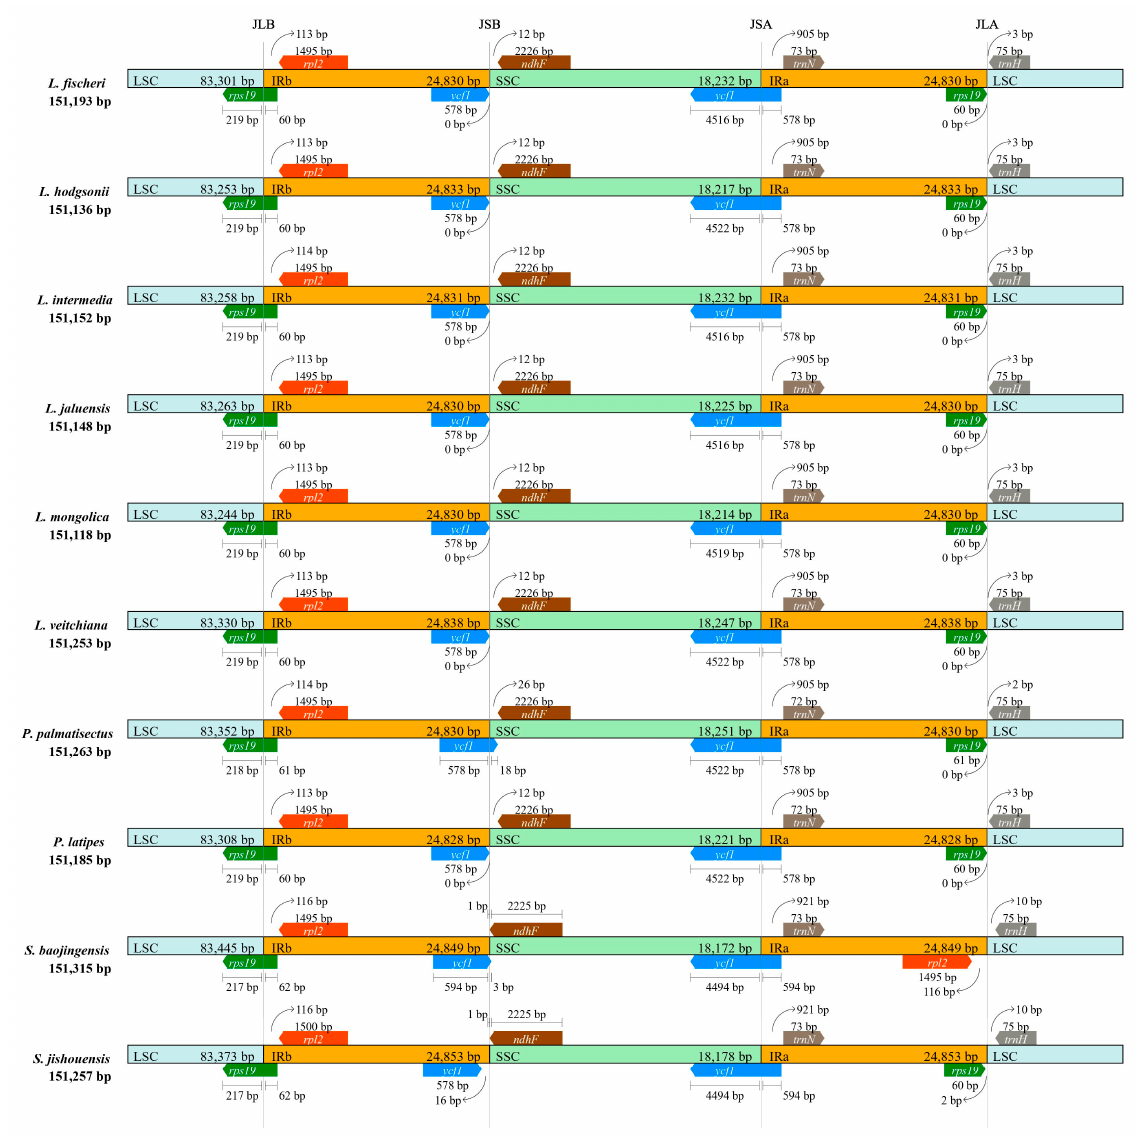
Figure 5. Comparison of the border positions of LSC, SSC, and IR regions among cp genomes from 10 Senecioneae species. Gene names are indicated in boxes.